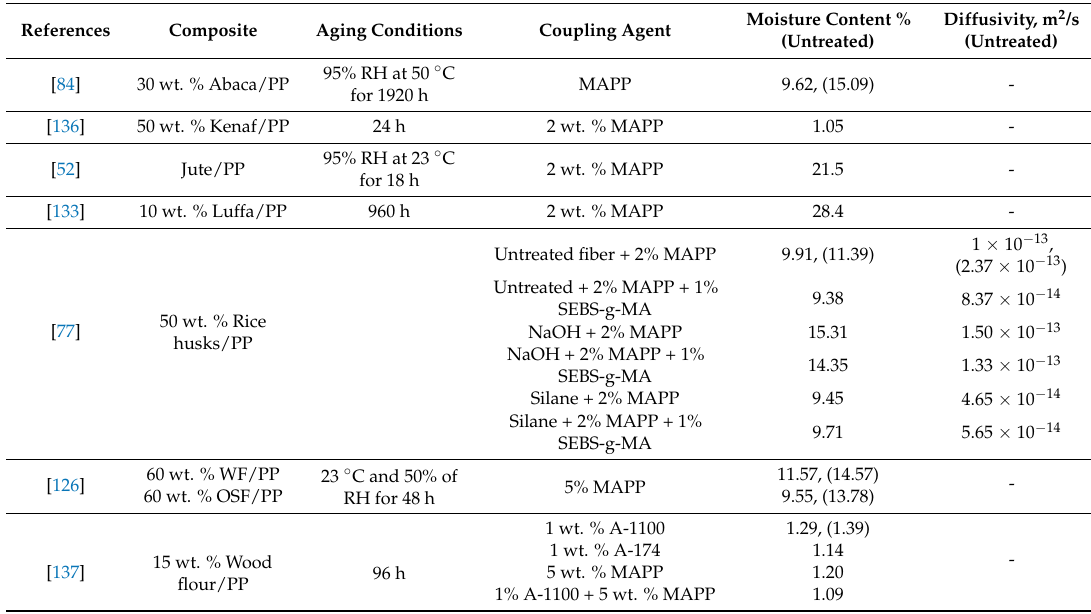
Table 2. The effect of MA grafting on moisture absorption